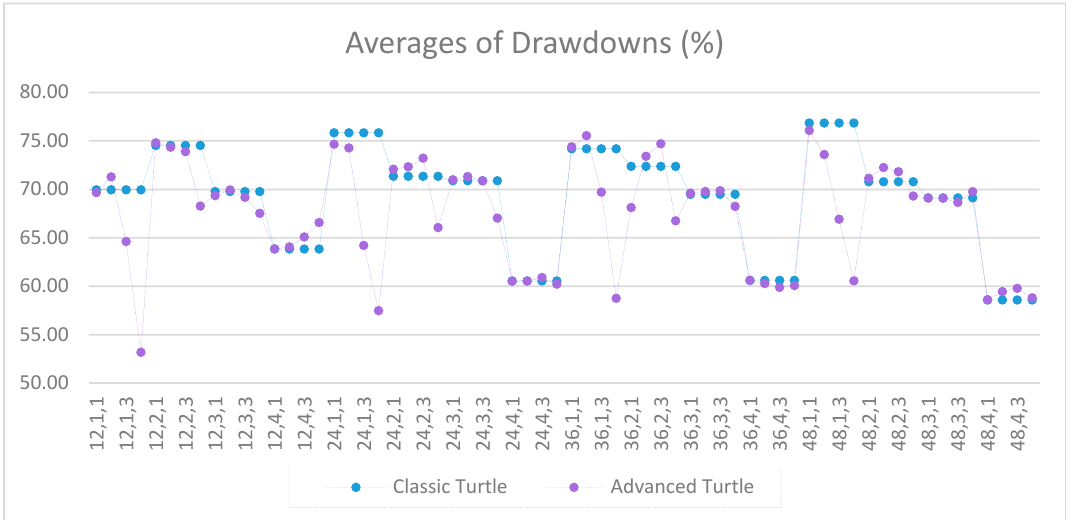
Figure 13. Averages of profits between the classic and the advanced Turtle systems for every combination of N, X, Y for the slow parameters (80, 160).